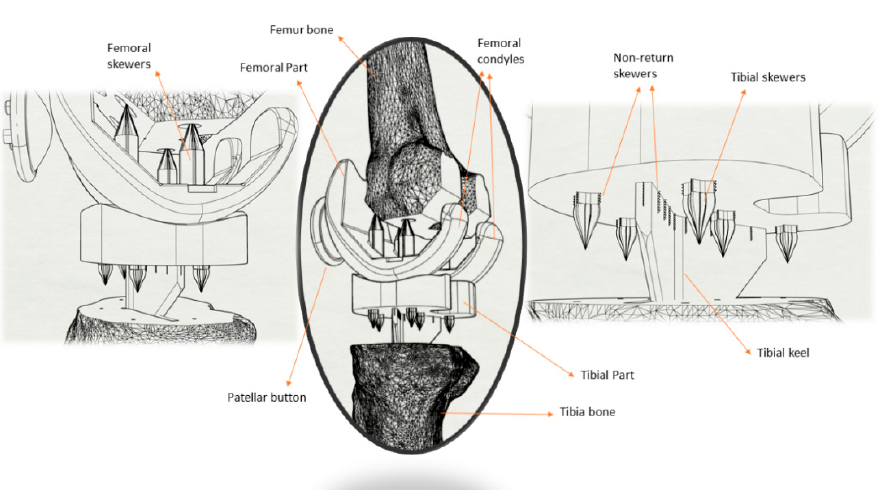
Figure 2. Characteristics of the new bicomponent knee prosthesis proposal.